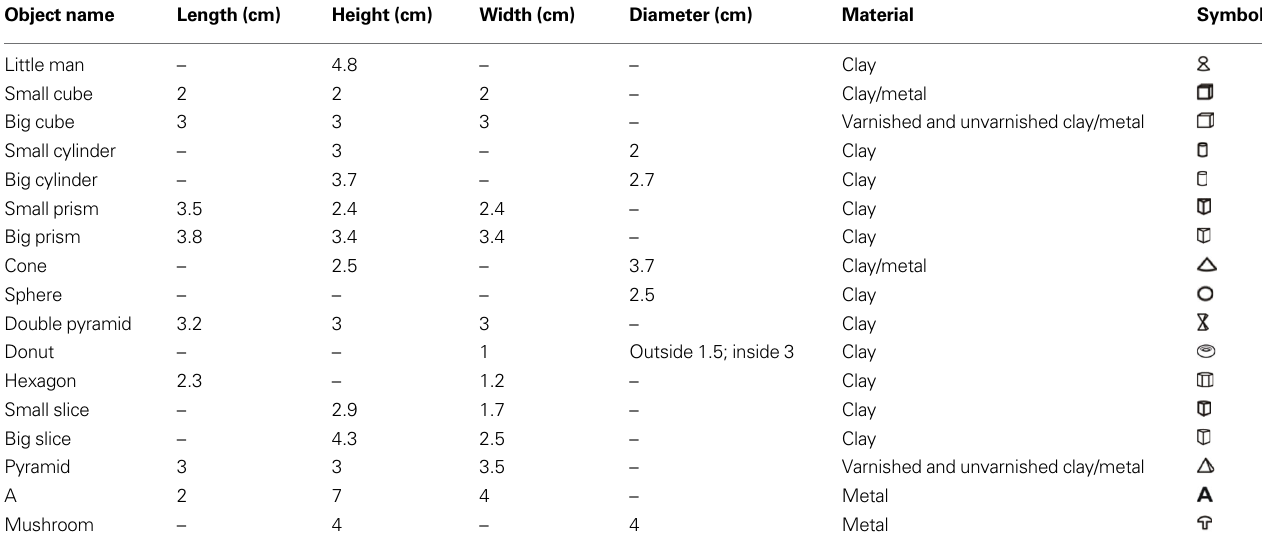
Table 1 | Measures, names, and symbols of all objects used in the experiments. Concerning the color of the objects, all clay objects (varnished and unvarnished) were white, while all metal objects had a typical metal (aluminium)